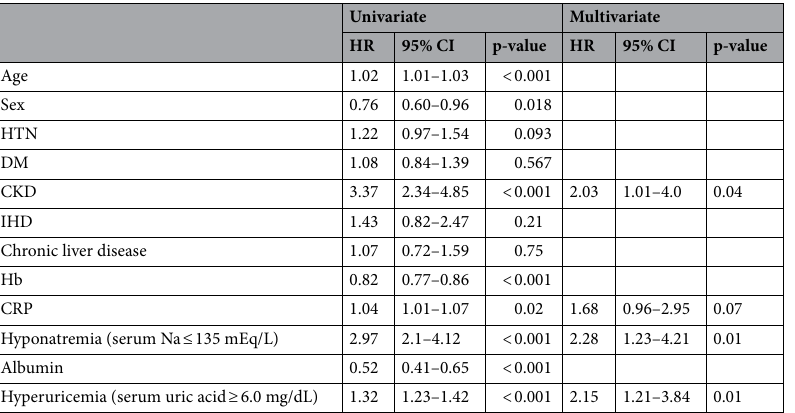
Table 3. Logistic regression analysis of factors associated with AKI. Multiple logistic regression analysis was conducted after adjustment for sex, age, hypertension, diabetes mellitus, ischemic heart disease, chronic liver disease, chronic kidney disease (eGFR ≤ 60 ml/min/1.73 m 2 ), Hb, hyponatremia (serum Na ≤ 135 mg/d),